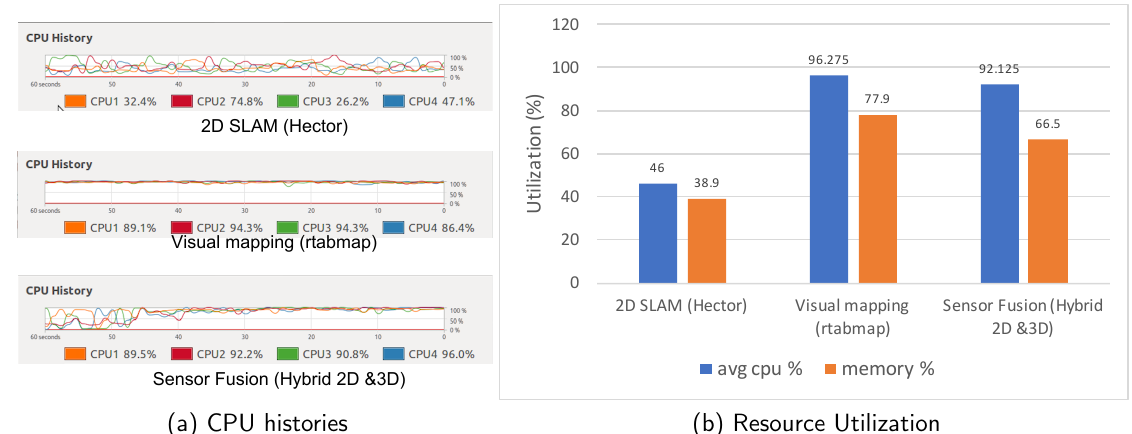
Figure 19. The 3D mapping (point cloud) result of the indoor